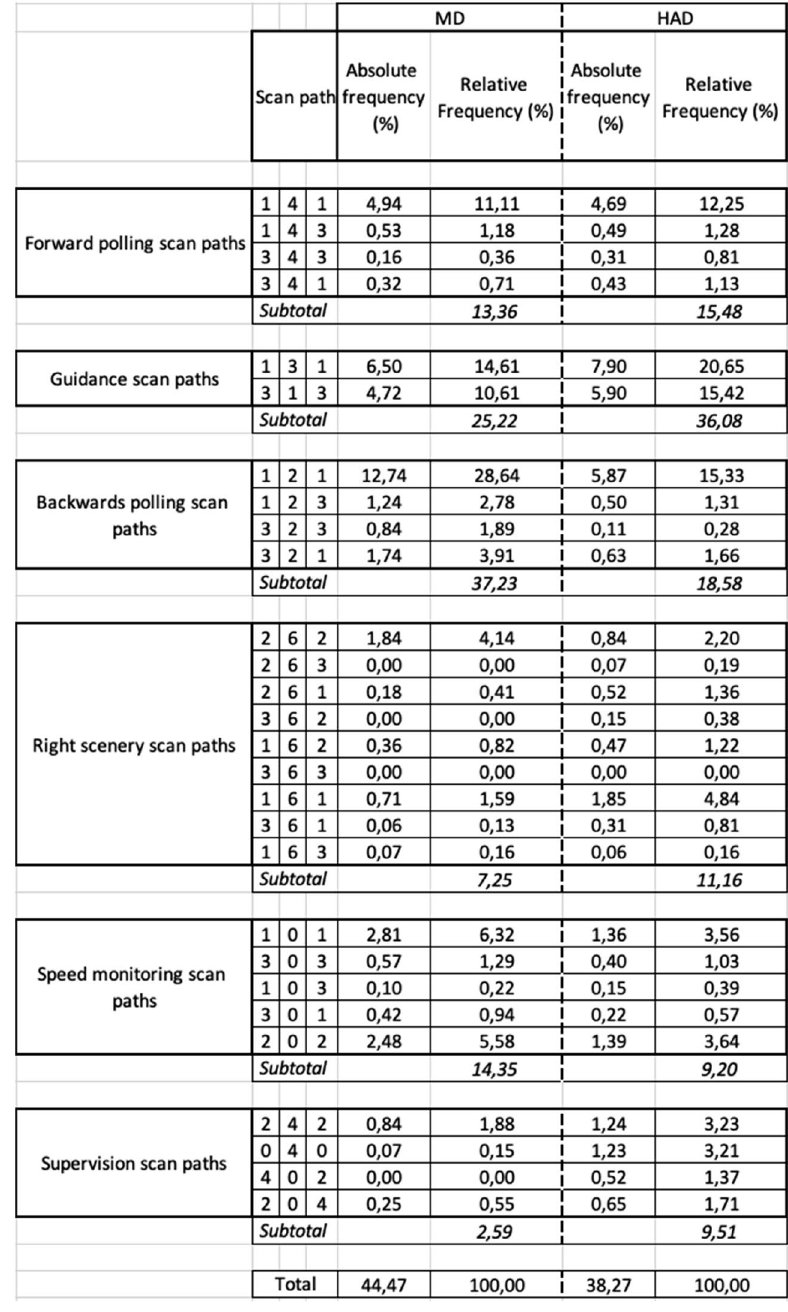
Table 3. Absolute and relative frequencies of the 28 triplet scan path sequences derived from the six classes in Manual Driving (MD) and Highly Automated Driving (HAD). Given are each scan path absolute frequency (%) in the entire dataset, and relative frequency for the subset of the predefined 28 scan paths sequences